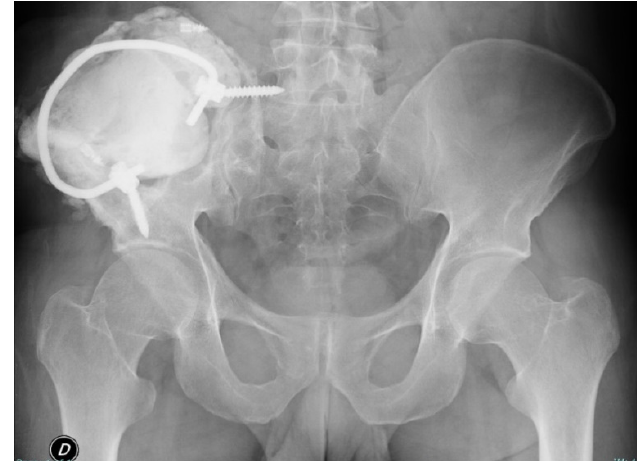
Figure 5. One-month post-operative radiograph control.